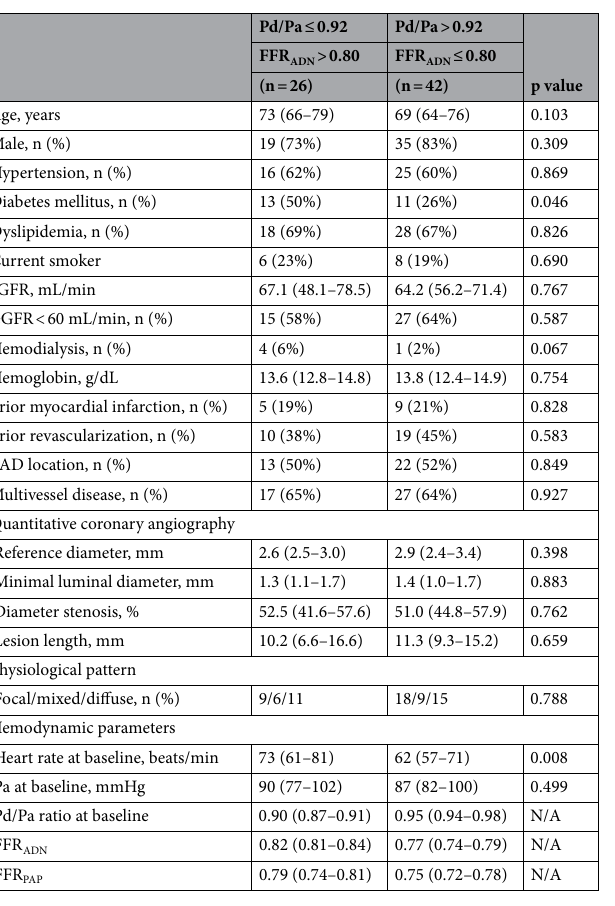
Table 2. Comparison between two discordant groups. Values are expressed as medians (interquartile ranges) or numbers (percentages). eGFR estimated glomerular rate, FFR ADN fractional flow reserve value associated with adenosine, FFR PAP fractional flow reserve value associated with papaverine, LAD left anterior descending coronary artery, N/A not applicable, Pa mean aortic pressure, Pd mean distal coronary